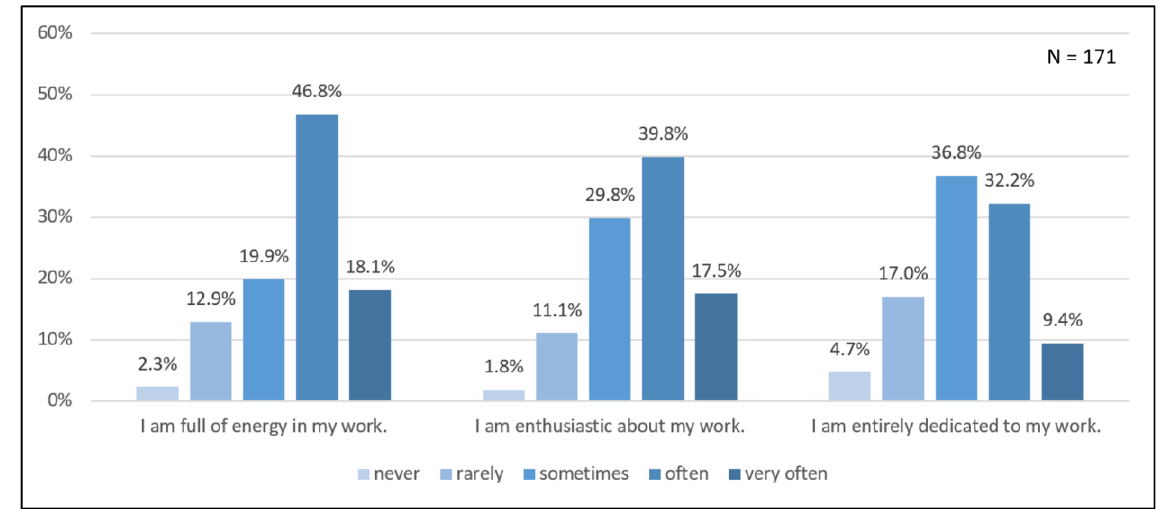
Figure 2. Aspects of work engagement among outpatient caregivers. The responses ( N = 171) of the three items were correlated ( r = 0.60, p < 0.01), and Cronbach’s alpha ( α = 0.82) indicated a good internal consistency. Table 2. Length of breaks spent at the different break locations as compared with in a break room. Break Locations Compared to